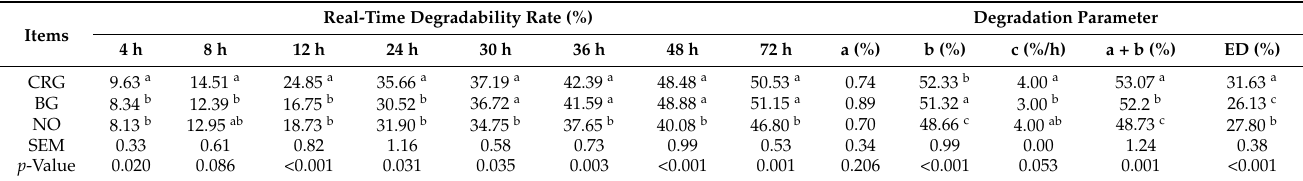
Table 6. Rumen real-time degradability and degradation parameters of ADF for three forages (CRG, BG, and NO).